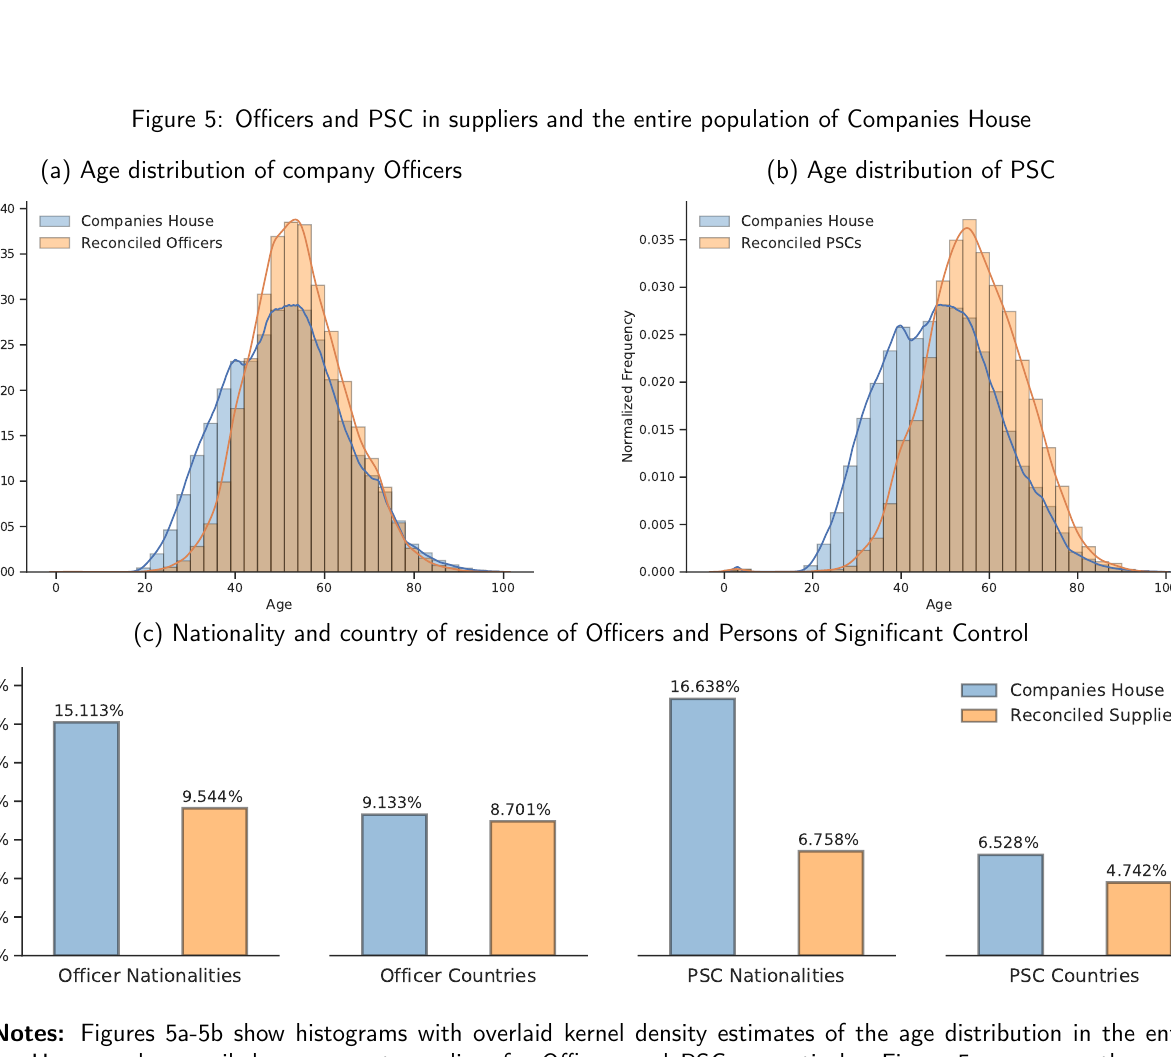
Figure Notes: Figures 5a-5b show histograms with overlaid kernel density estimates of the age distribution in the entirety of Companies House and reconciled government suppliers for Officers and PSC respectively. Figure 5c compares the number of UK and non-UK nationals and UK and non-UK countries of residence across both Officers and PSC, comparing the entirety of Companies House and reconciled government